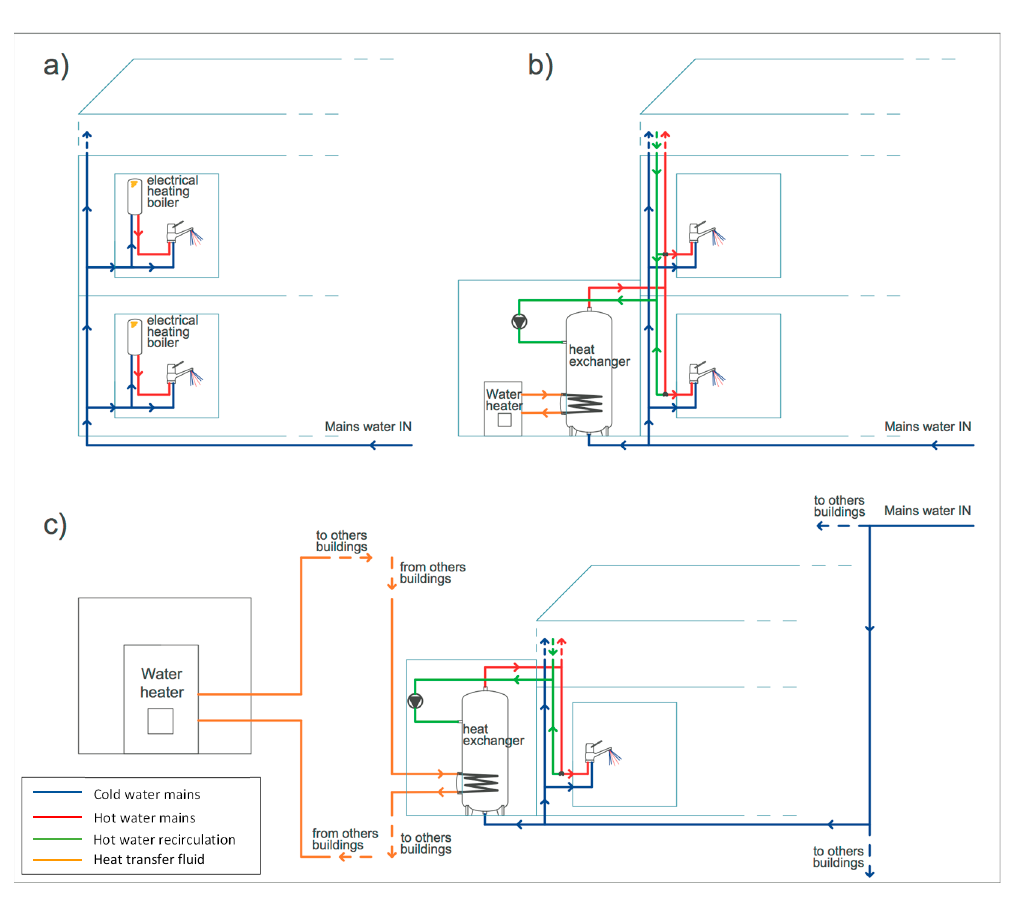
Figure 5. Hot-water production and distribution systems of campus ( a ) No. 5, ( b ) No. 3, and ( c ) No. 6.